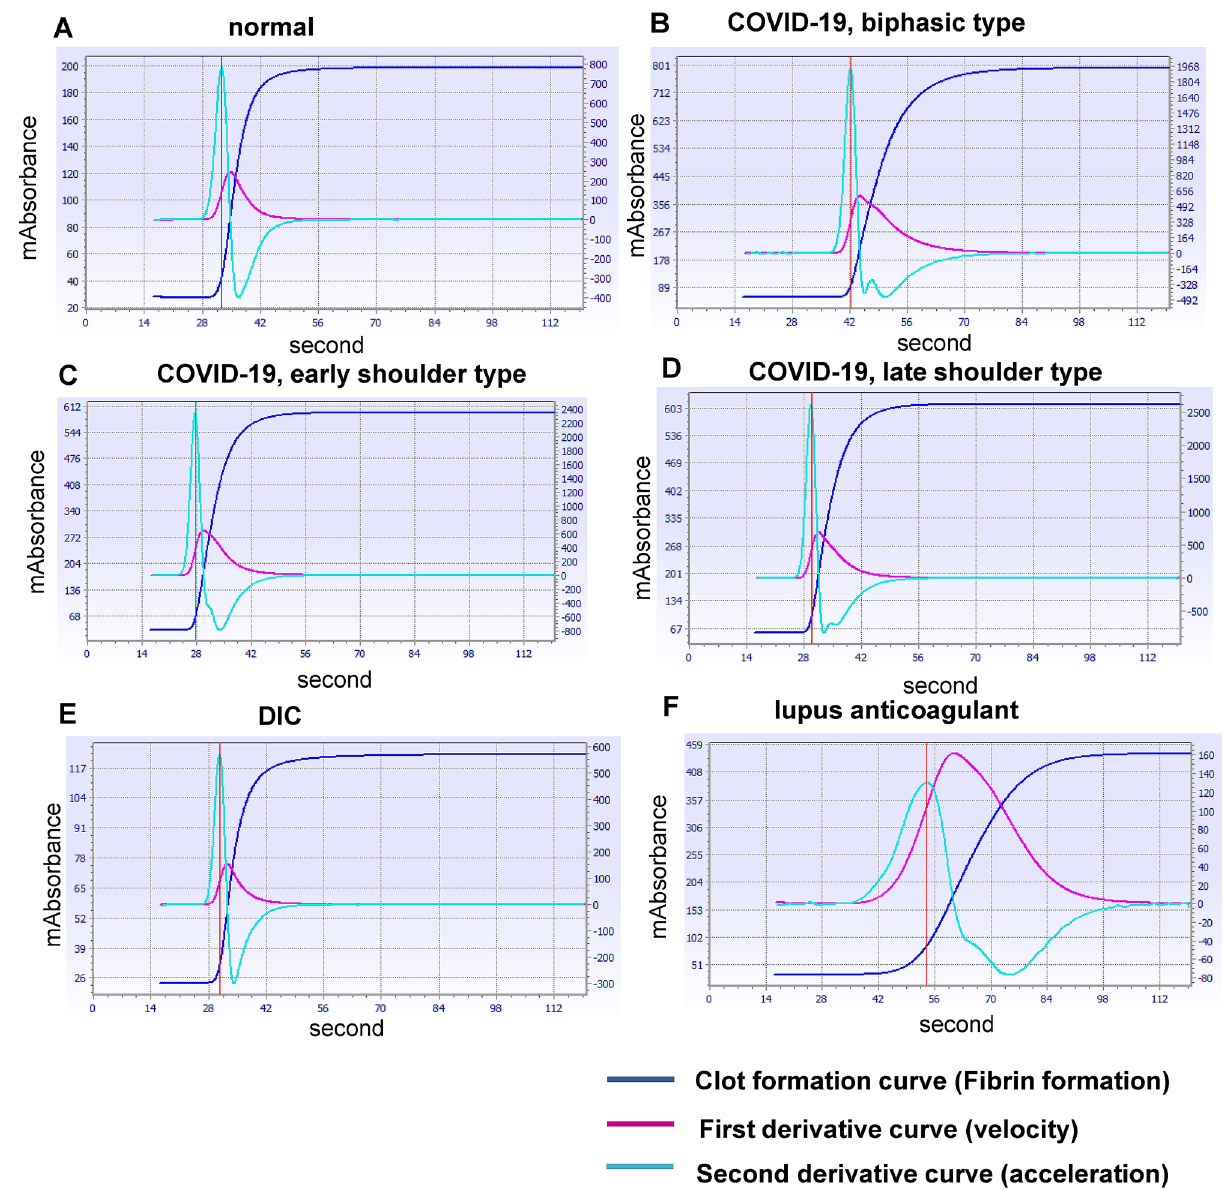
Figure 1. Representative APTT clot waveforms in COVID-19 and other subjects. Representative APTT clot waveforms in COVID-19 and other subjects are shown. ( A ) Normal subject, ( B – D ) COVID-19 subjects, ( E ) DIC subject, and ( F ) subject with lupus